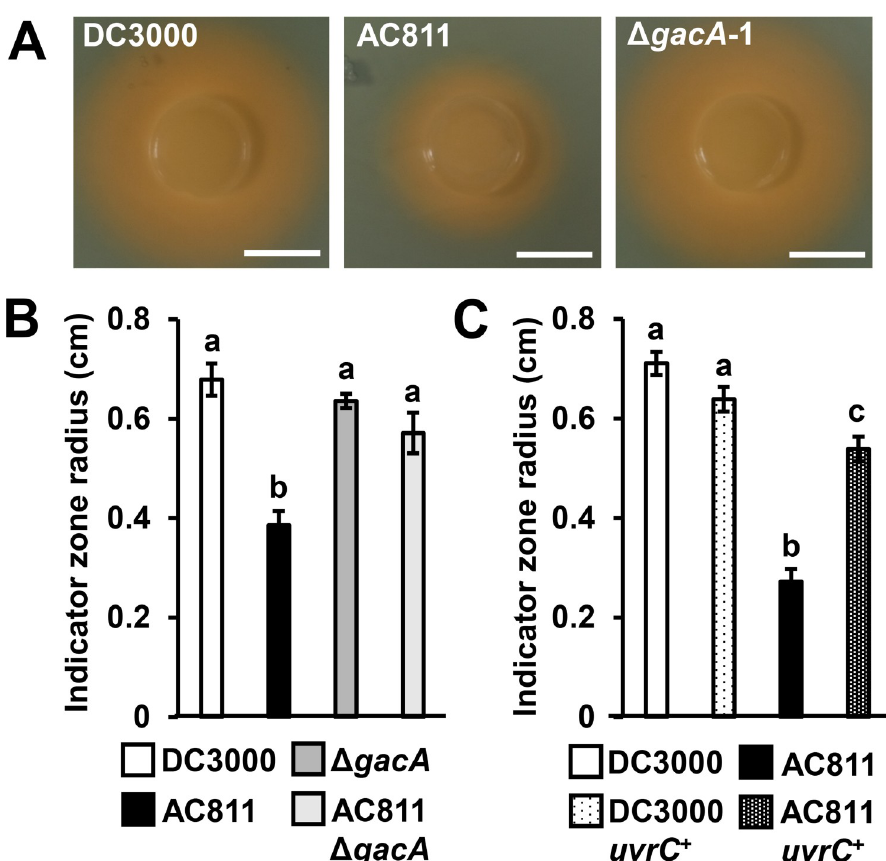
Fig 5. Siderophore production by DC3000 is gacA -independent. Siderophore production of DC3000, AC811, and Δ gacA was detected on CAS blue agar plates. (A) Photographs of agar plates showing fluorescent siderophore production, visible as an orange halo surrounding the bacterial colony. White bar is scale of 1 cm. Results are representative of three independent experiments. (B) Radii of indicator zone from strains carrying either pME6010 empty vector or pME6010:: uvrC . Graphed are means ± SE of data pooled from two independent experiments; n = 7. (C) Radii (cm) of the zone of indicator color change were measured from the edge of bacterial colony. Graphed are means ± SE of data pooled from three independent experiments; n = 9. Small case letters in (B) and (C) denote statistical groupings determined by ANOVA with multiple pairwise t -test comparisons and Tukey’s post-hoc HSD analysis, p < 0.05.